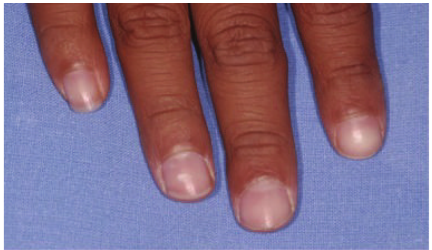
Figure 2: Brittle nails.